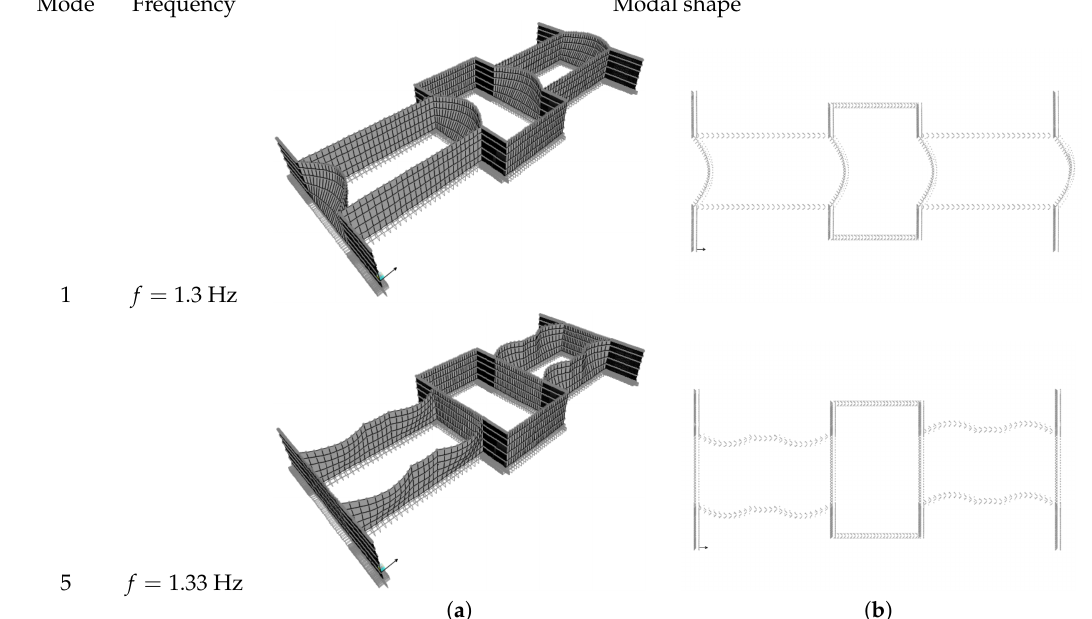
Figure 22. Natural modes of the global SLTW homogenized model. Modal shape in the ( a ) 3D space; ( b ) x − z